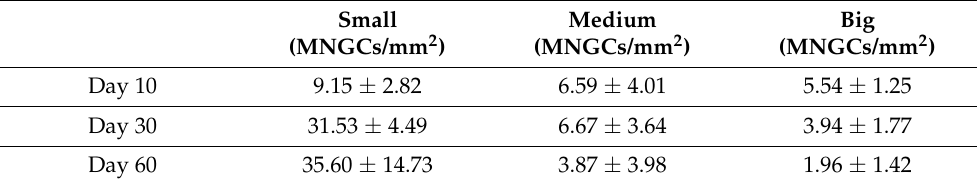
Figure 5. Histomorphometrical results of the occurrence of multinucleated giant cells (MNGCs) (intraindividual: *** p < 0.001, interindividual: ## p < 0.01 and ### p < 0.001). Red: small granules, green: medium-sized granules, and blue: big granules. Table 3. Results of the histomorphometrical measurements of MNGCs.